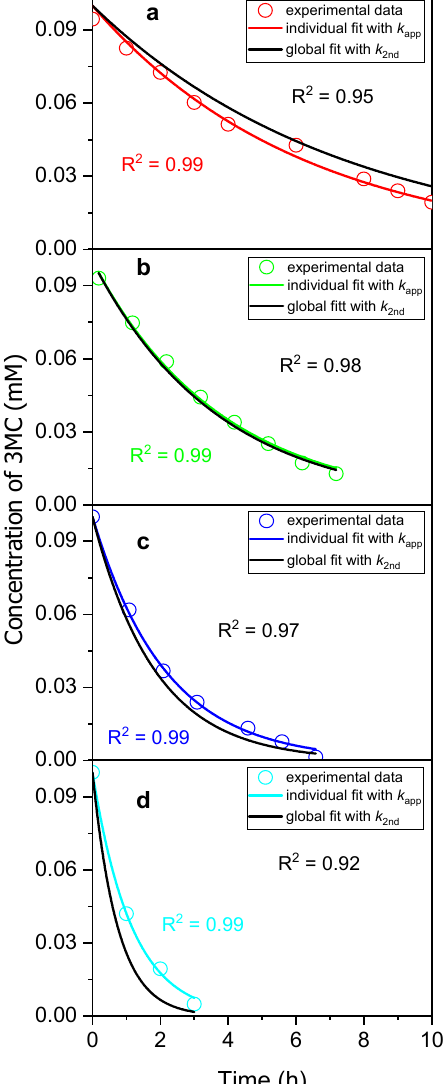
Figure 2. 3-methylcatechol (3MC) degradation in aqueous solution at different initial concentrations of NaNO 2 (pH = 4.5–5, T = 25 °C). The concentrations of NaNO 2 were 0.5 ( a ), 1.0 ( b ), 2.0 ( c ), and 5.0 mM ( d ). Experimental data (symbols) and calculated time-dependent concentration profiles (lines) for the pseudo-first order ( k app ) and global second order ( k 2nd (global)) fits.